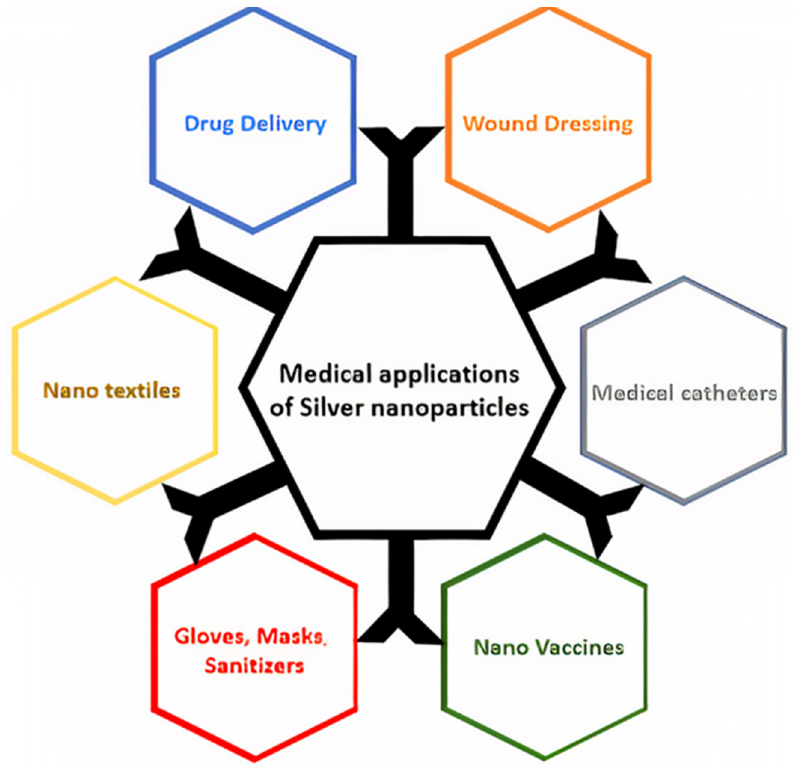
Figure 9. Application of silver nanoparticles in the medical field.